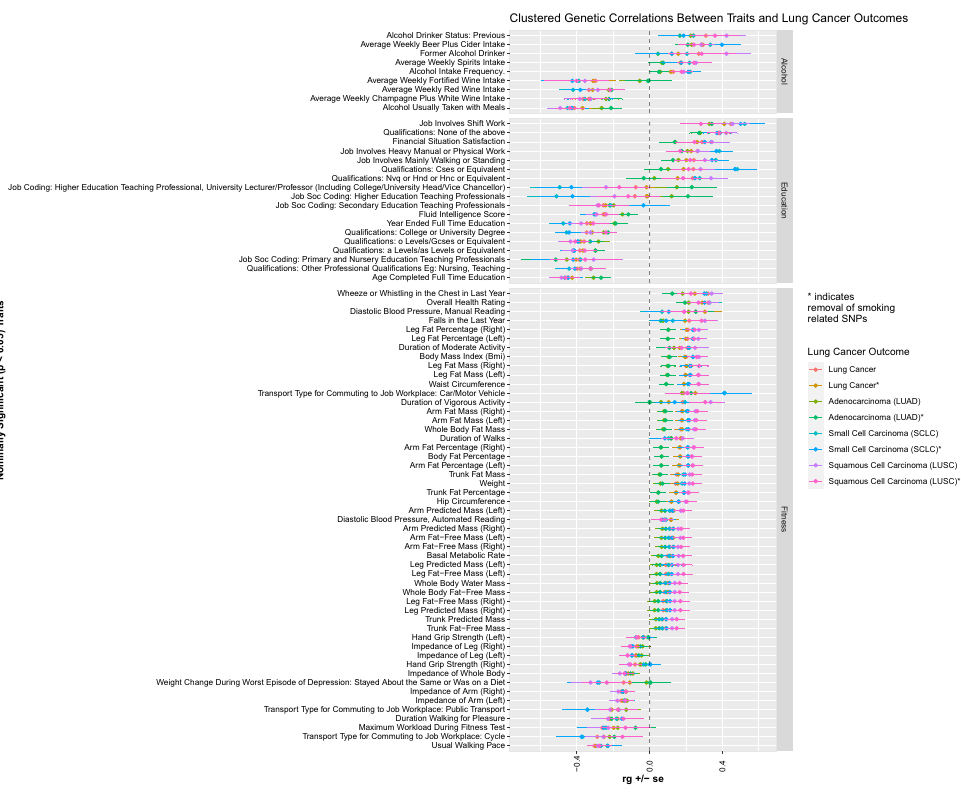
Figure 7. Overlapping forest plot of nominally significant trait associations with lung cancer outcomes clustered by alcohol use, educational ascertainment and fitness